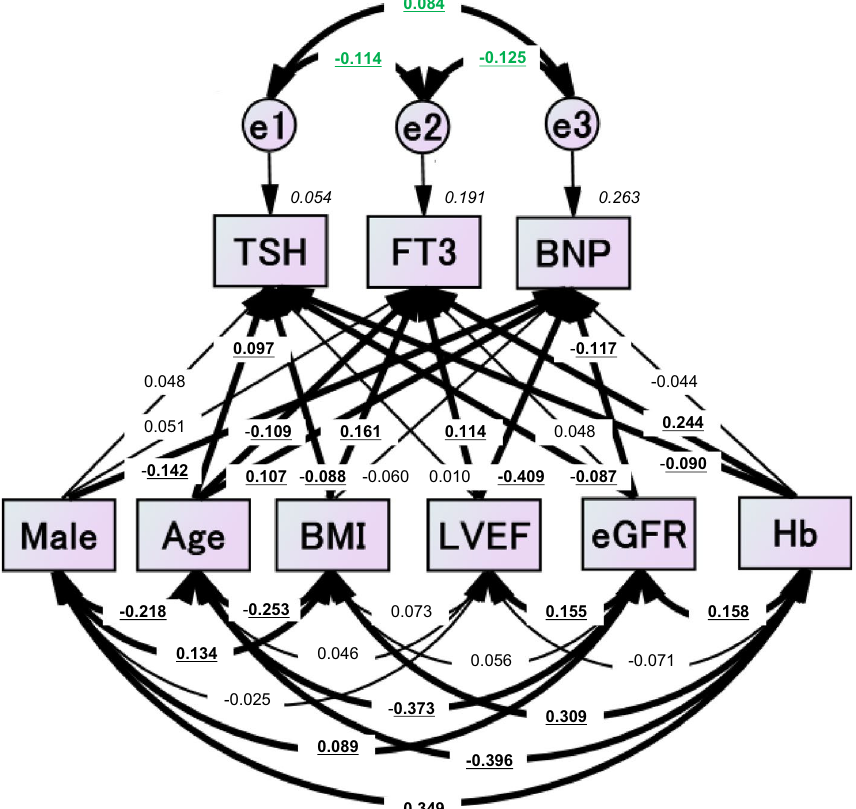
Figure 1. Path model (A) (the whole BNP group). The path model theoretically proposed to clarify the contribution of sex (male), age, BMI, LVEF, eGFR, or Hb to TSH, FT3 or BNP. The analysis was performed on all cases. Each path has a coefficient representing the standardized coefficient of a regressing independent variable on a dependent variable of the relevant path. These variables represent the standardized regression coefficients (direct effect) and squared multiple correlations (in narrow italics) as well as the correlations among exogenous variables (green). BMI, body mass index; LVEF, left ventricular ejection fraction; eGFR, estimated glomerular filtration rate; Hb, hemoglobin; TSH, thyroid-stimulating hormone; FT3, free triiodothyronine; BNP, B-type natriuretic